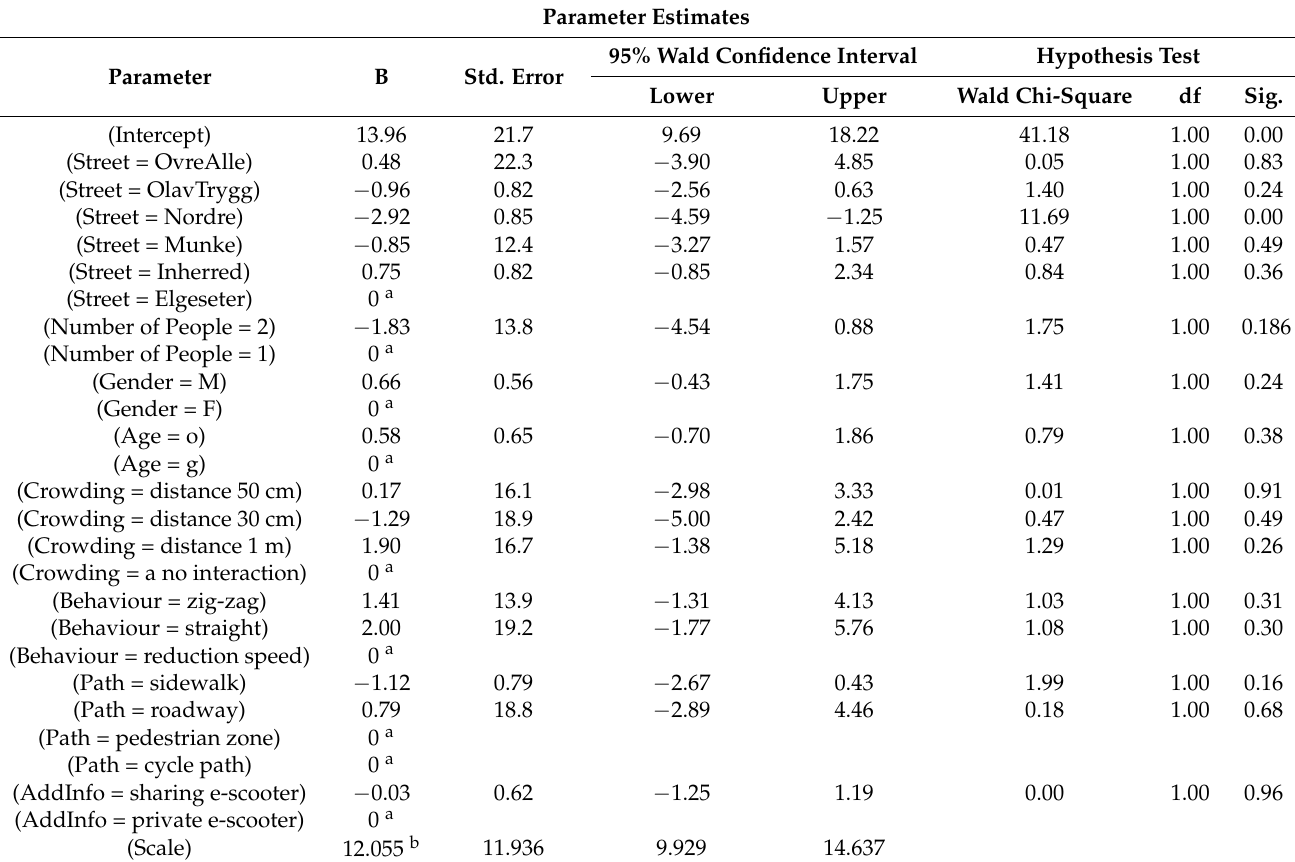
Table 2. Parameter